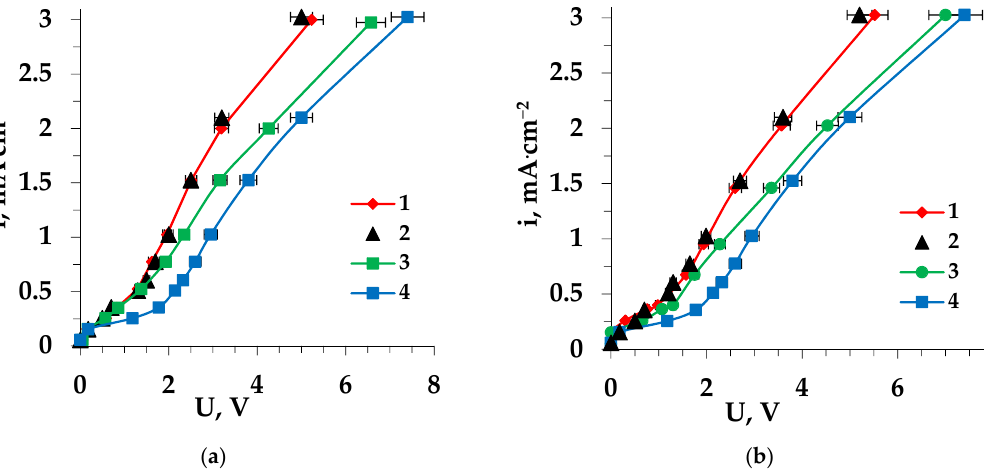
Figure 2. Current-voltage characteristics of the MK-40 cation-exchange membrane in the electrodialysis of Trp + NaCl ( a ) and Pro + NaCl ( b ) solutions: 1—pristine membrane, 2—regenerated membrane, 3—fouled membrane; 4—pristine membrane in the ED of NaCl solution.